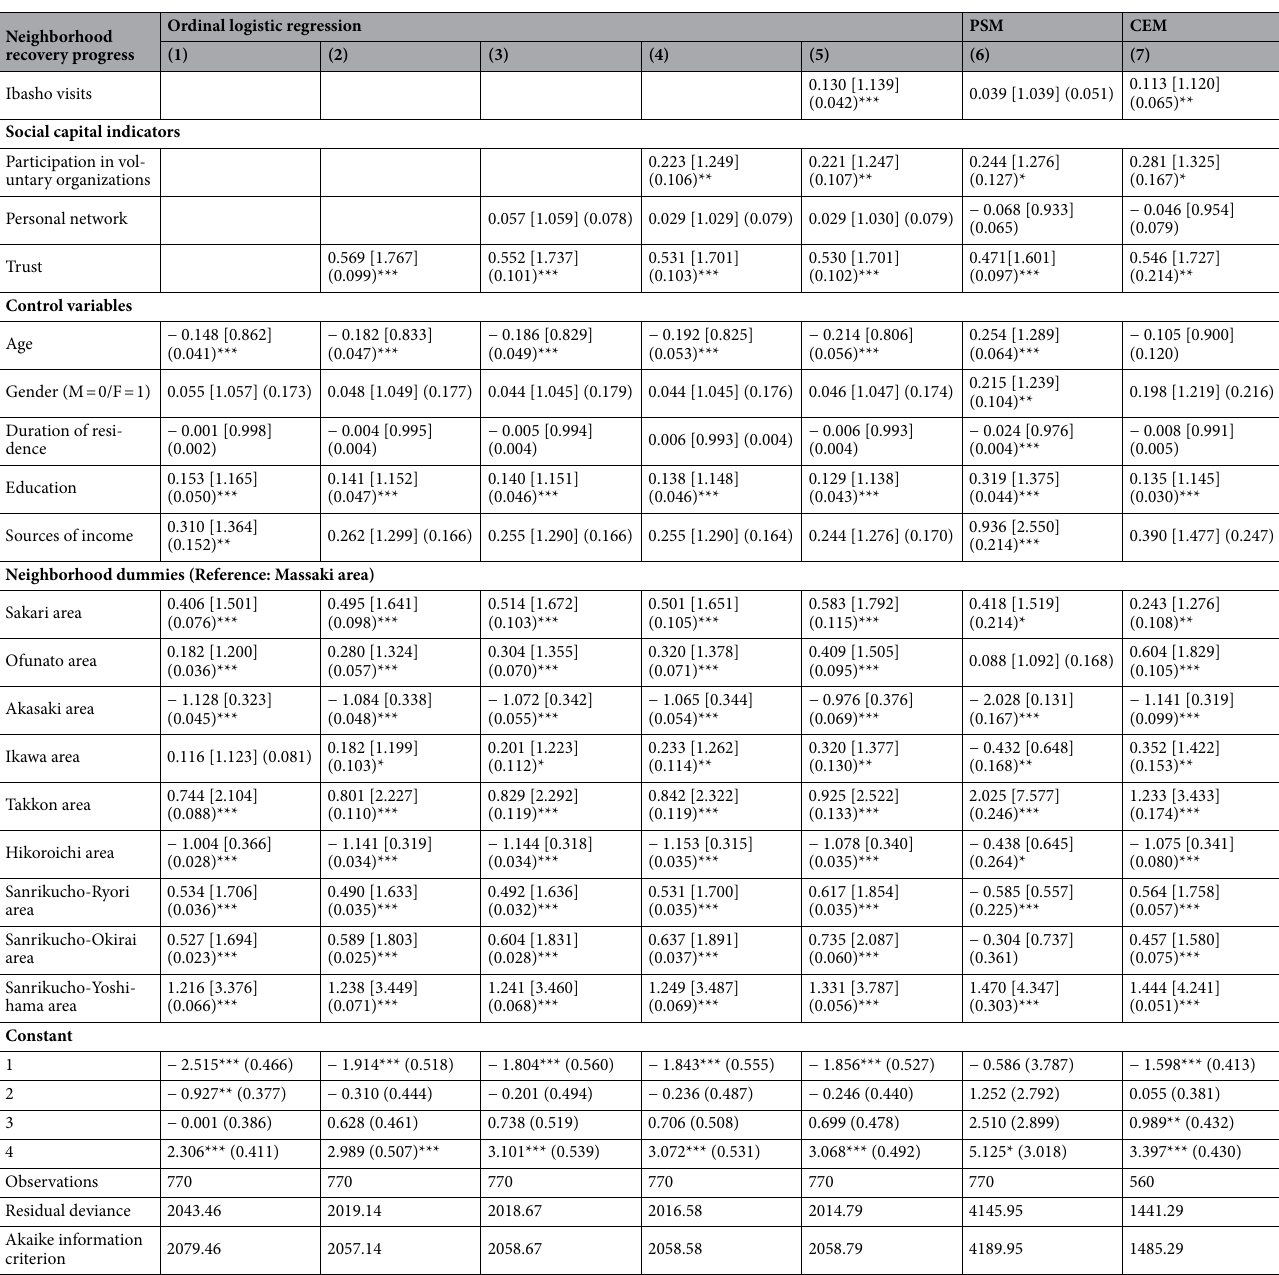
Table 4. Regression of neighborhood recovery progress on Ibasho visits and social capital indicators. *p < 0.1; **p < 0.05; ***p < 0.01; Odds ratios are reported in square brackets; standard errors (in parentheses) are clustered by